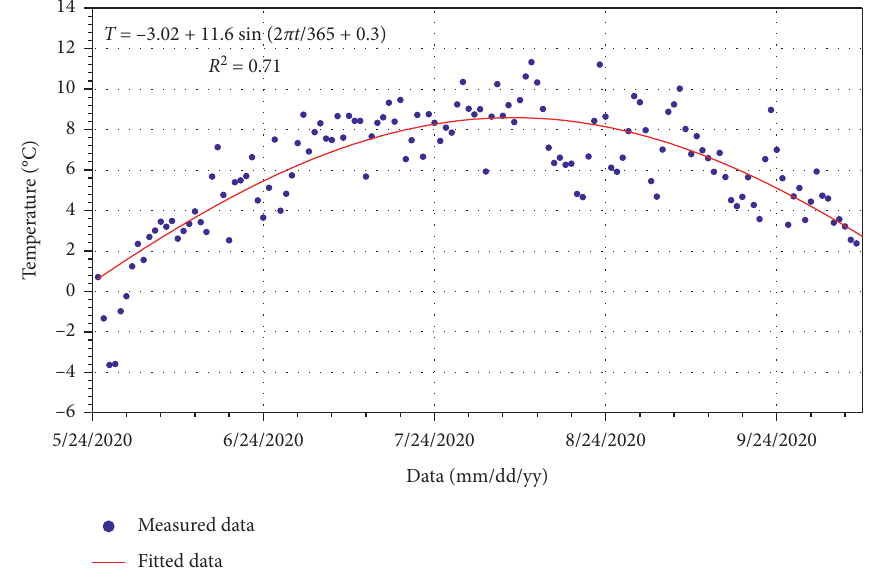
Figure 1: Observed air temperatures at the channel from May 24 to November 10, 2020.